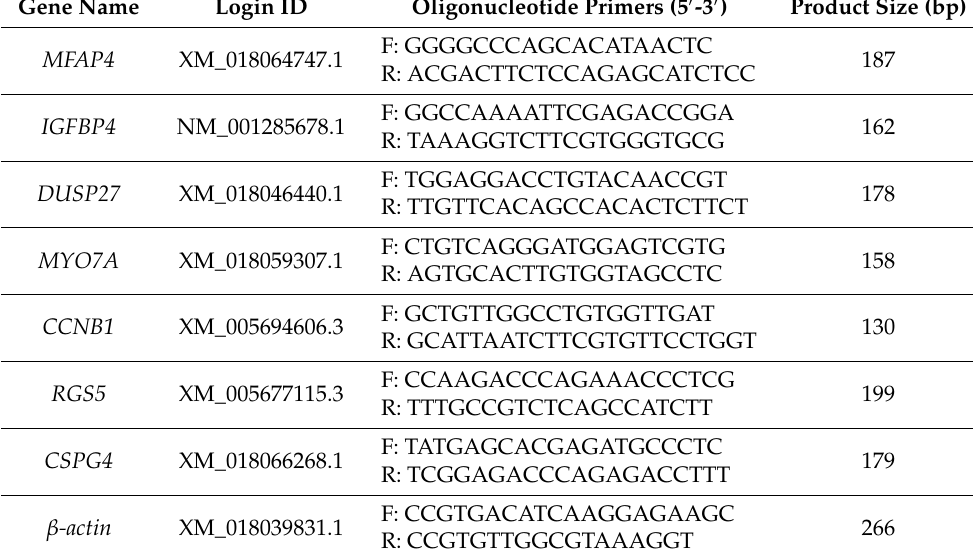
Table 1. The primers for